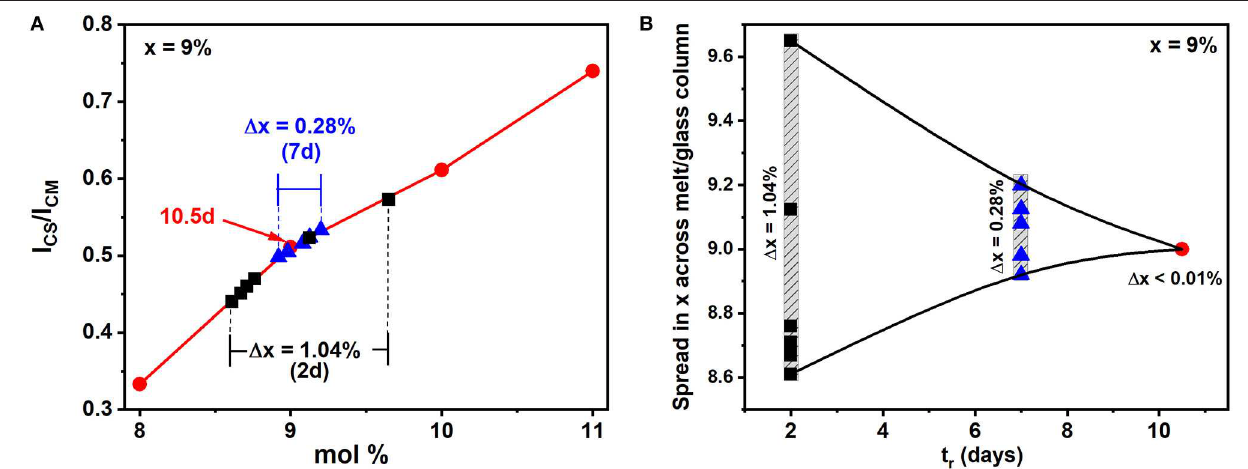
FIGURE 6 | (A) From the fully homogenized glasses we established the red, empirical correlation of the Raman scattering strength ratios with weighed glass composition once that composition has been homogenized in the FT-Raman profiling experiments, describing the variation in the scattering strength ratio of the Corner-Sharing mode near 200 cm − 1 to the broad Se n chain band near 250 cm − 1 . The six spectra plotted in Figure 1 are normalized to the highest scattering strength band near 250 cm − 1 , and the spread in the CS mode strength after 2 days of alloying provides a visual measure of glass heterogeneity. These data are plotted as the black squares in the plot above. Upon alloying the glass for 7 days, the variance in Ge content of the glass decreased to 0.28%, and then became minuscule ( < 0.01%) after 10.5 days of alloying. (B) An alternative representation of melt homogenization can be displayed by plotting the variance <1 × > in Ge stoichiometry deduced from FT-Raman profiling of a 1.5-g batch composition weighed at x = 9% and its composition tracked as a function of t r , the alloying time, at 950 ◦ C in days. Note that the variance decreases by 2 orders of magnitude in going from 2d (1.04%) to 10.5d (0.01%) and yields the expected weighed composition at x =